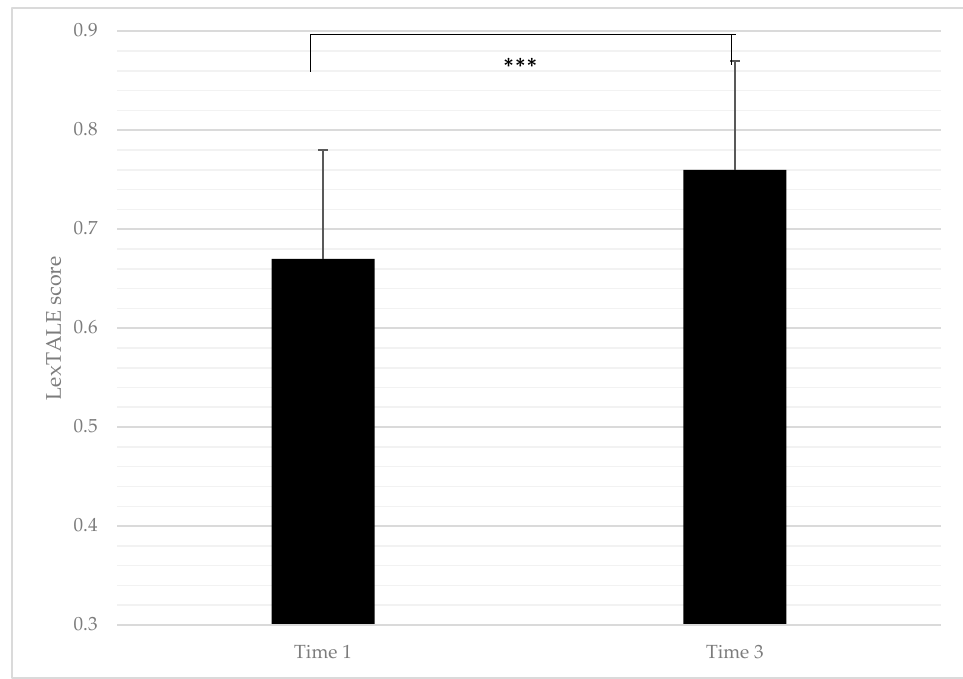
Figure 1. Group mean for actual proficiency at Time 1 and Time 3 (*** p < 0.001).